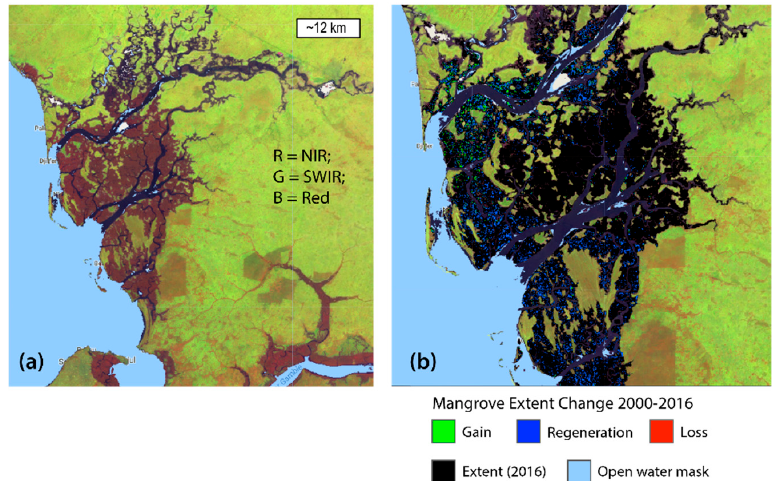
Figure 8. ( a ) The near-infrared, short-wave infrared, and red bands from Landsat 8 OLI were used to make this 2016 false-color composite of the Kaolack Region of Senegal. ( b ) Changes in mangrove cover in the Kaolack Region of Senegal between 2000 and 2016.